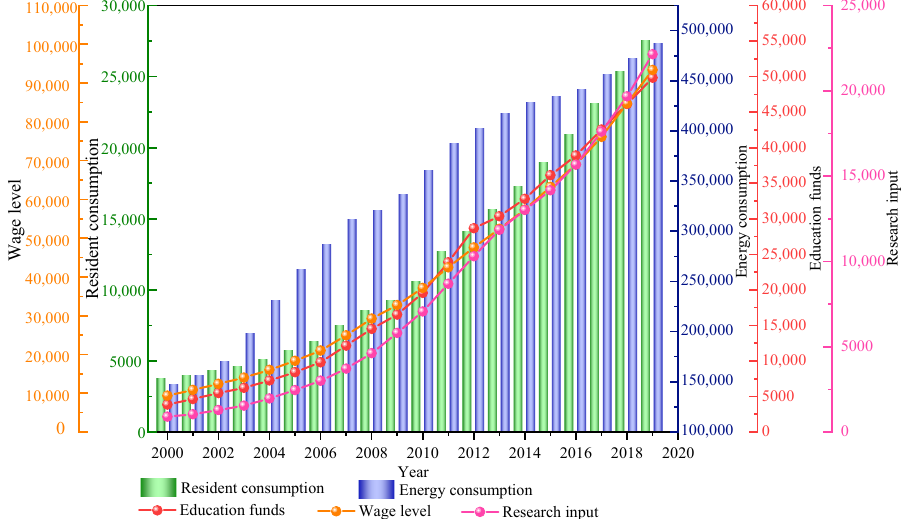
Figure 5. The changing trend of China’s economic indicators year by year.